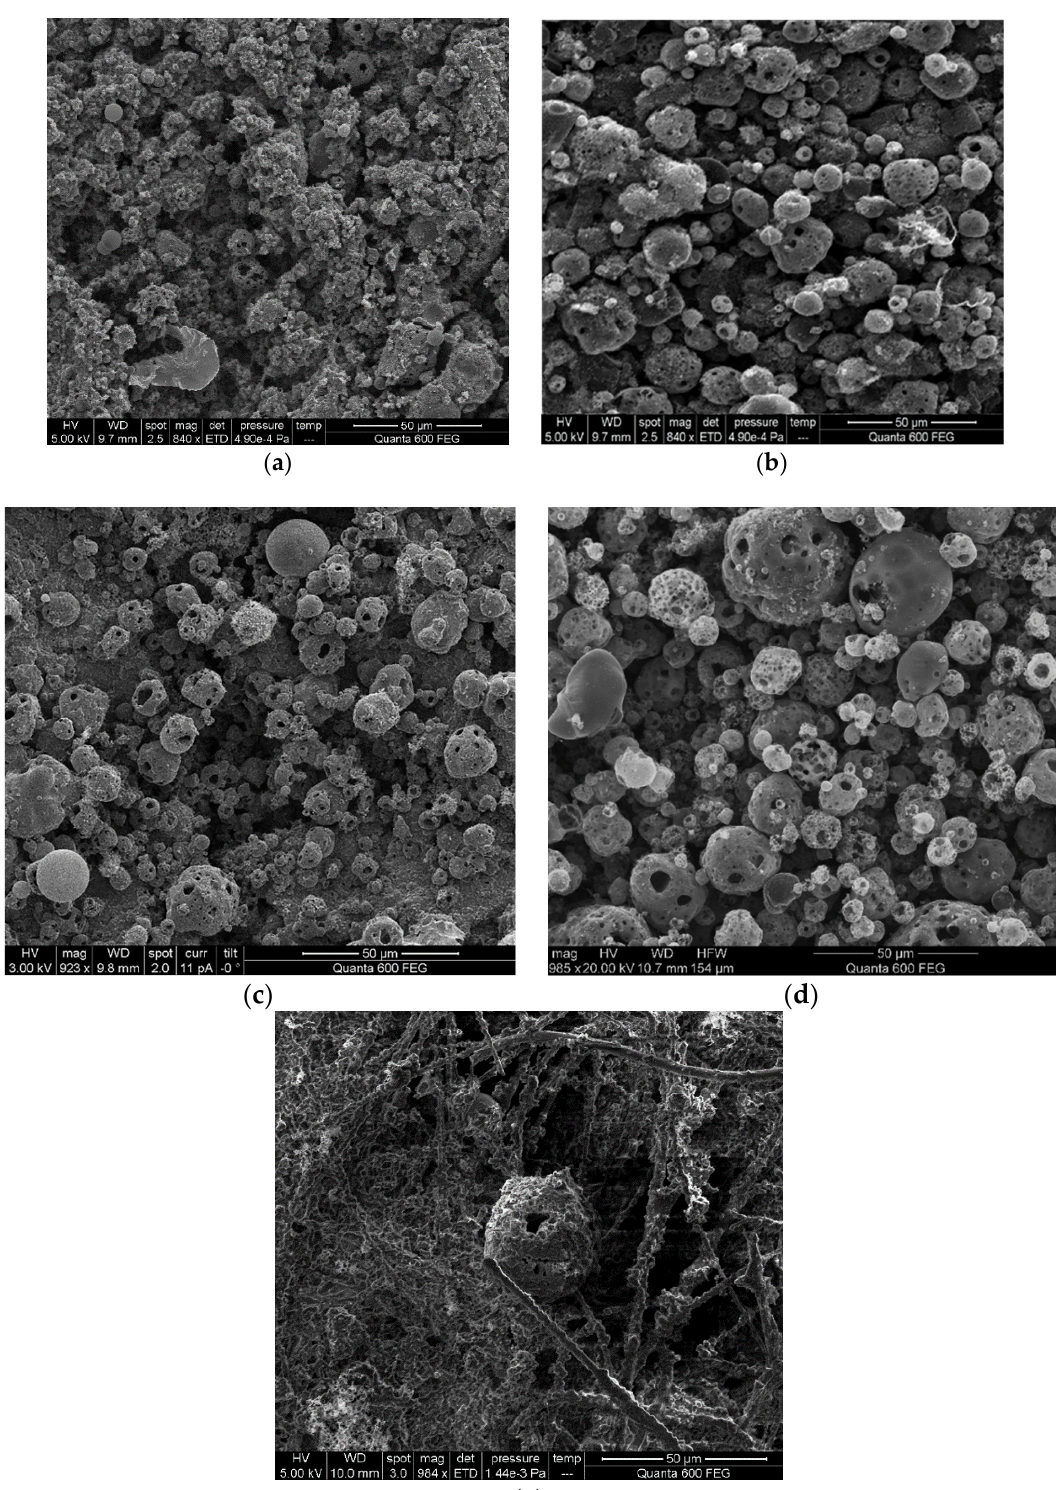
Figure 8. Morphology of the solid particle emissions from fuel combustion with various asphaltene contents. ( a ) 4% asphaltene HFO. ( b ) 6% asphaltene HFO. ( c ) 8% asphaltene HFO. ( d ) 16% asphaltene HFO. ( e ) 24% asphaltene HFO.